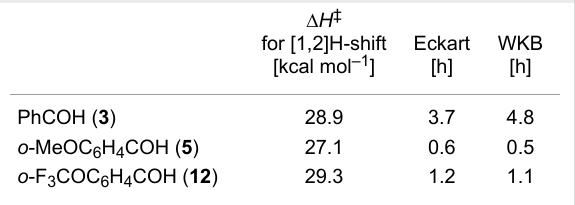
Table 1: Computed half-lives ( unscaled ) for the [1,2]H-tunneling reac- tion in carbenes 3 , 5 , and 12 at 11 K. The measured half-life of 3 is 2.5 h at 11 K. The thermal barrier for the [1,2]H-shift was computed at AE-CCSD(T)/cc-pVDZ // M06-2X/cc-pVDZ; (cf. Computational